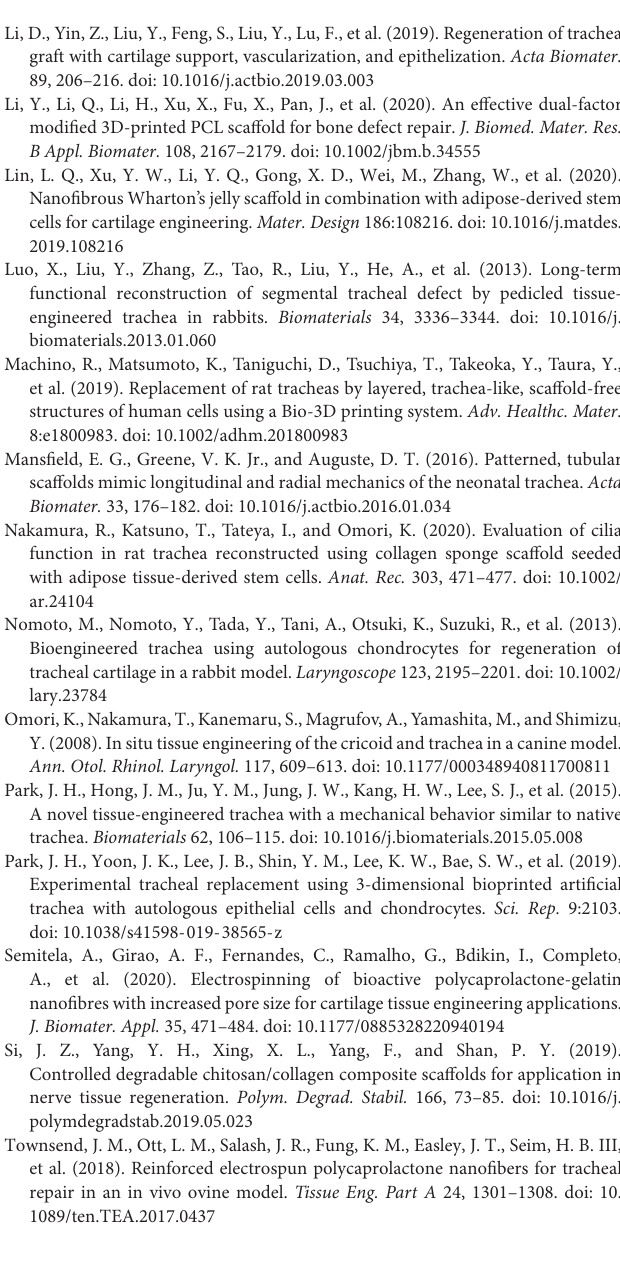
Supplementary Table 1 | Postoperative evaluation of rabbits. Supplementary Video 1 | Radial rigidity of the biomimetic PCL